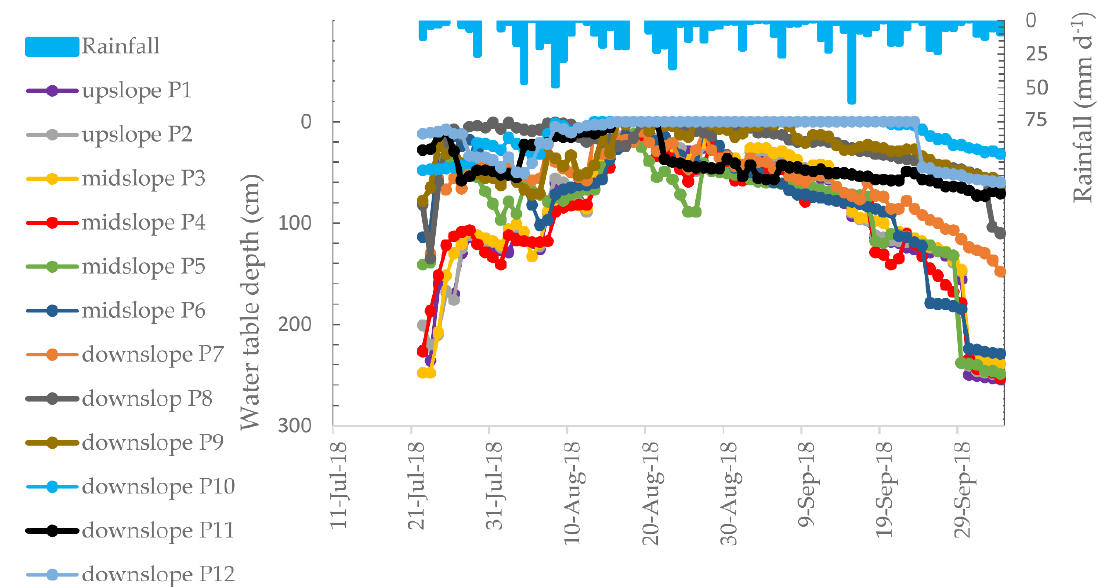
Figure 5. Water table depth for the slope positions in the Debre Mawi watershed.